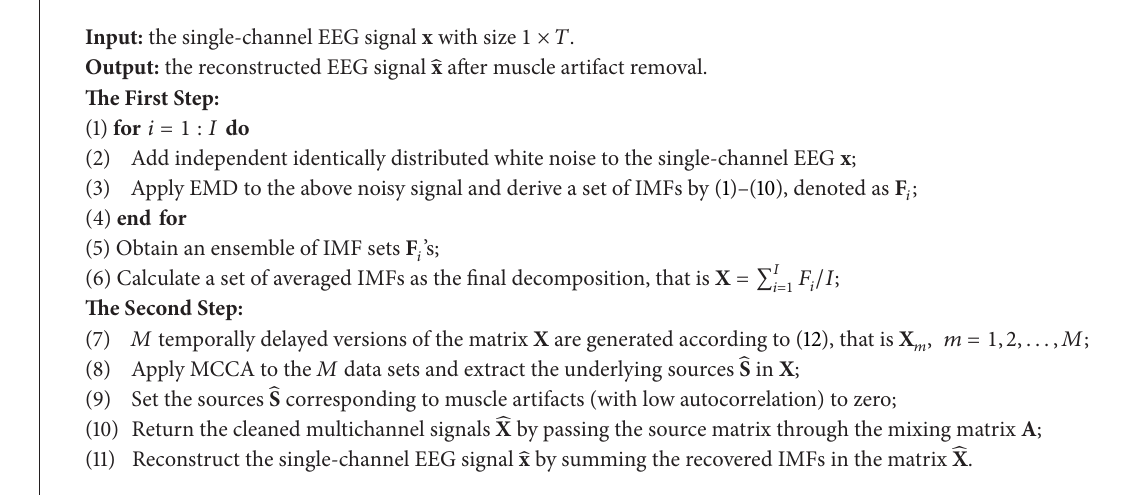
Algorithm 1: The EEMD-MCCA